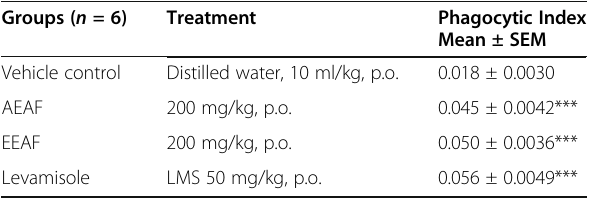
Table 10 Effect of aqueous and ethanolic extract of A . ficulneus L. leaves on carbon clearance test in mice Groups ( n = 6)